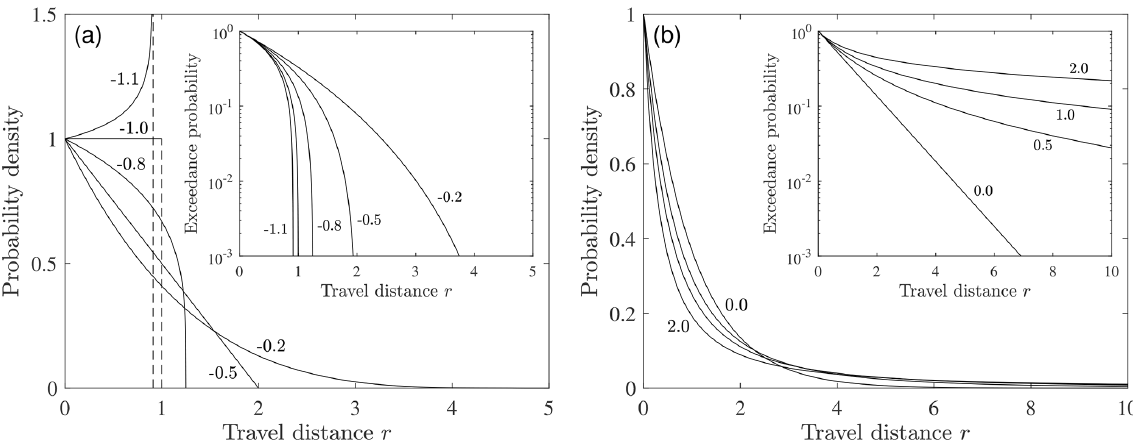
Figure 1. Plot of probability density f r ( r ; x ) versus travel distance r for scale parameter B = 1 and different values of the shape parameter A for (a) A < 0 and (b) A ≥ 0 with associated exceedance probability plots (insets). Figure reproduced from companion paper (Furbish et al., 2021a). Compare with Fig. 1 in Hosking and Wallis (1987).